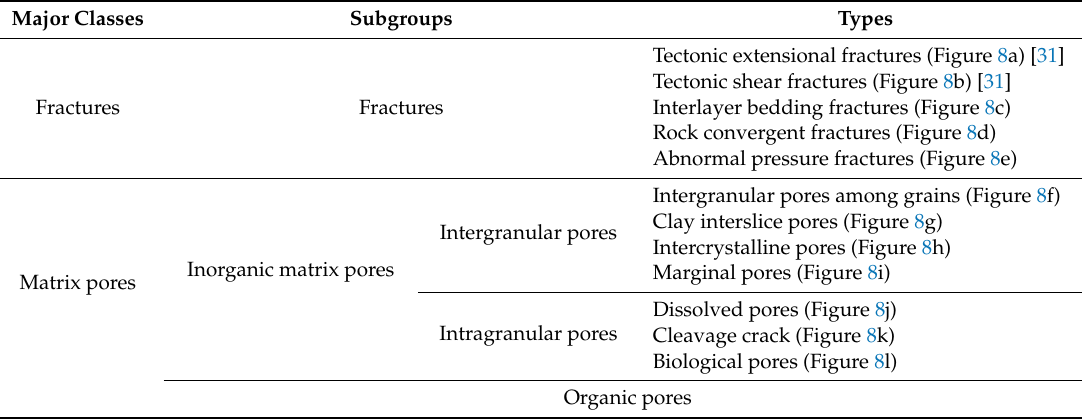
Table 3. Classification of storage space in shale